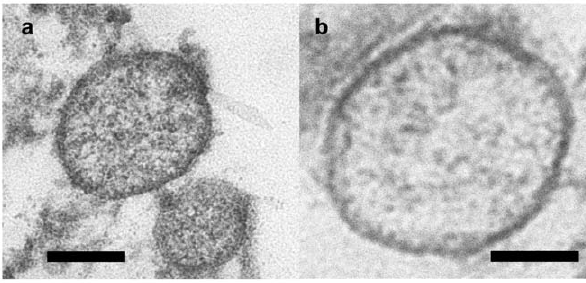
Figure 1. Transmission electron microscopy of purified micro- vesicles/exosomes. A) Microvesicles/exosomes displaying an electron dense appearance, and B) electron lucent appearance. Bar represents 100